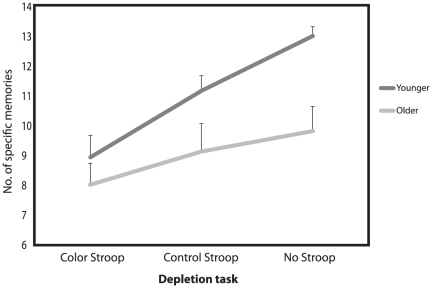
Autobiographical Memory Test performance across conditions.Mean (+1 SE) total numbers of specific memories across the Color Stroop, Control Stroop and No Stroop conditions on the Autobiographical Memory Test for the Younger and Older age groups.